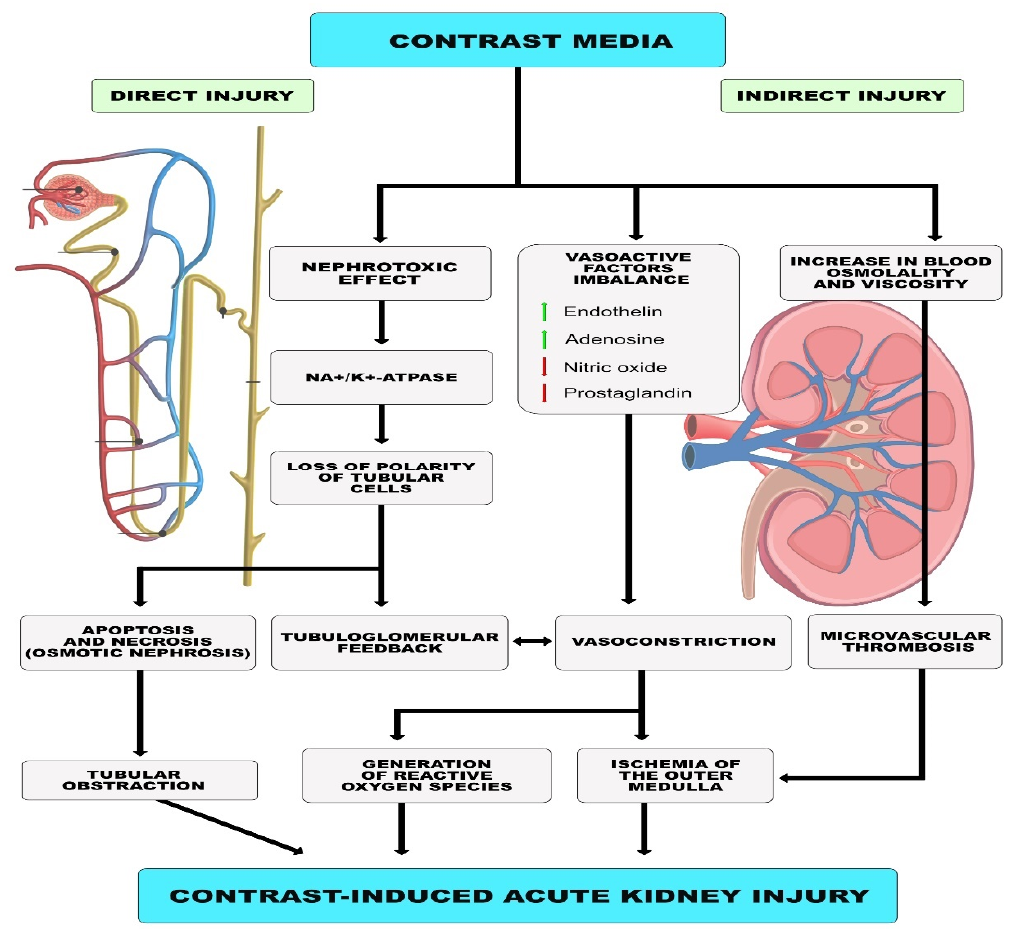
Figure 1. Proposed mechanism of contrast-induced acute kidney injury.